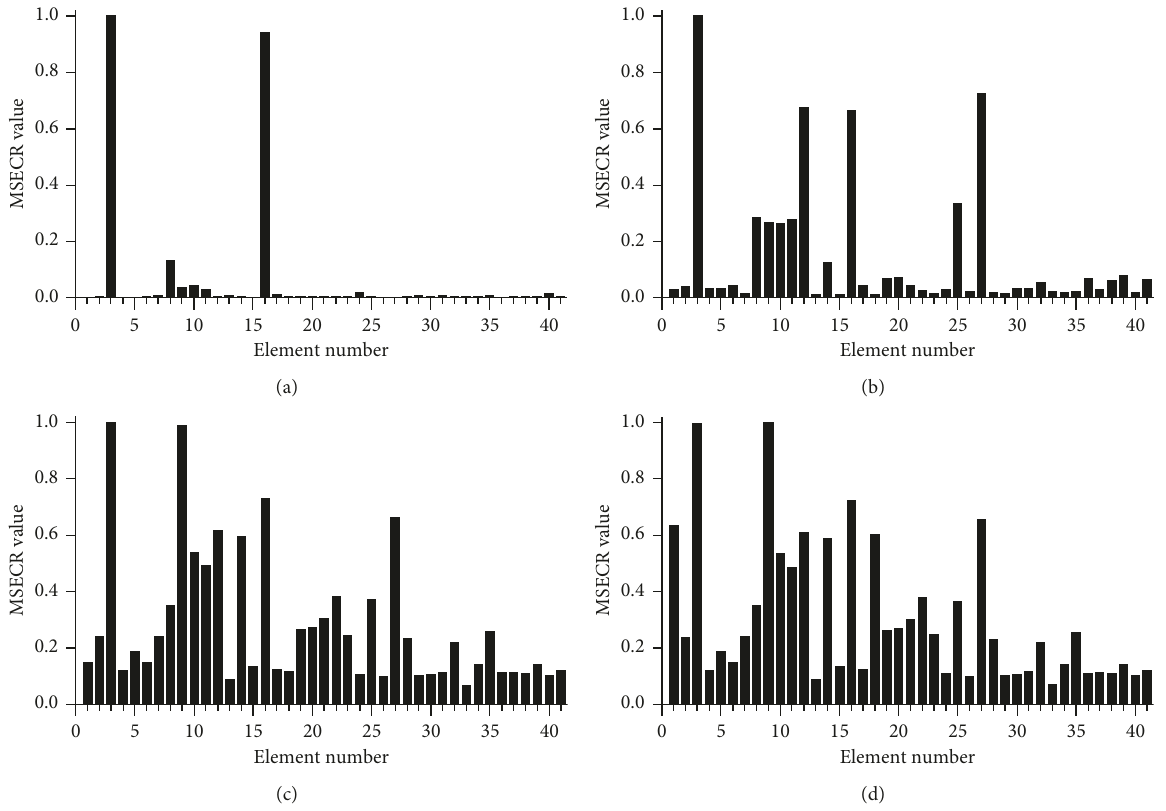
Figure 4: Values of the classic MSECR using the first several modes together (damaged element 9, without noise). (a) Using modes 1-2. (b) Using modes 1–4. (c) Using modes 1–6. (d) Using modes